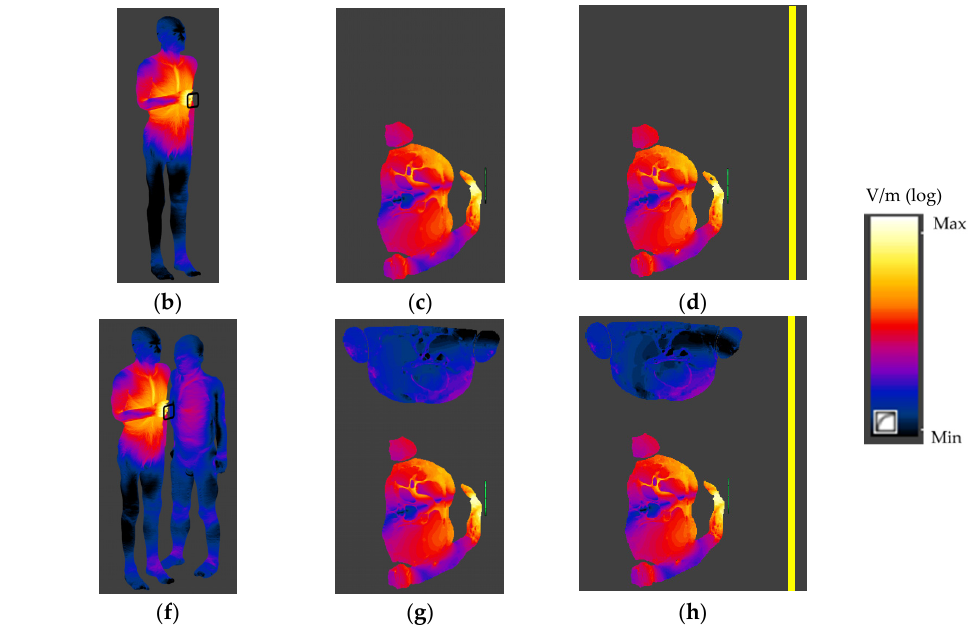
Figure 8. The normalised Ein distribution in the human body exposed to EMF near an HF RFID reader in various exposure scenarios: ( a – d ) a person using a PICC device; ( e – h ), a person using a PICC device and a bystander (side view ( a , b , e , f ) or horizontal cross-section perpendicular to the centre of the reader plane ( c , d , g , h ); reader on a vertical column ( a , c , e , g ) or attached to the vehicle cabin ( b , d , f , h ); logarithmic scale).